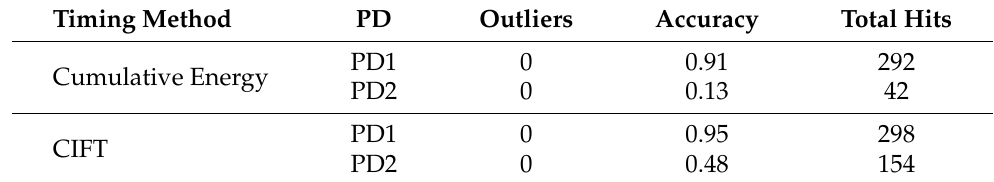
Table 3. Localization (table lookup) results with different timing methods and 300 mm